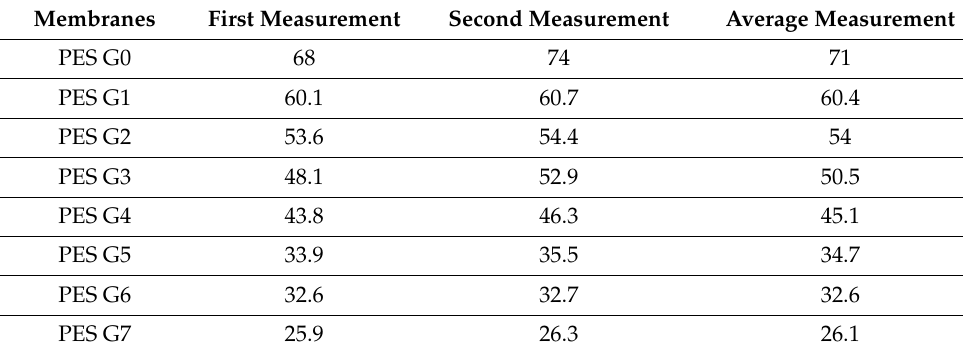
Table 3. Measured contact angle of the various membranes. Membranes First Measurement Second Measurement Average